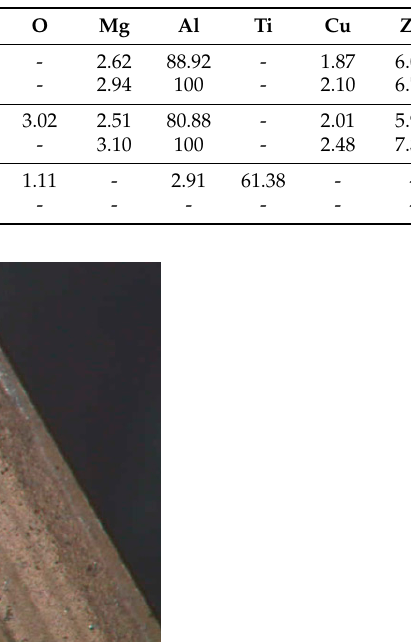
Figure 11. SOM image (30×) of the measurement process of S (f = 0.20 mm/r, v c = 170 m/min and a p = 2 mm). Figures 12–14 plot S as a function of f and v c , for each a p tested.